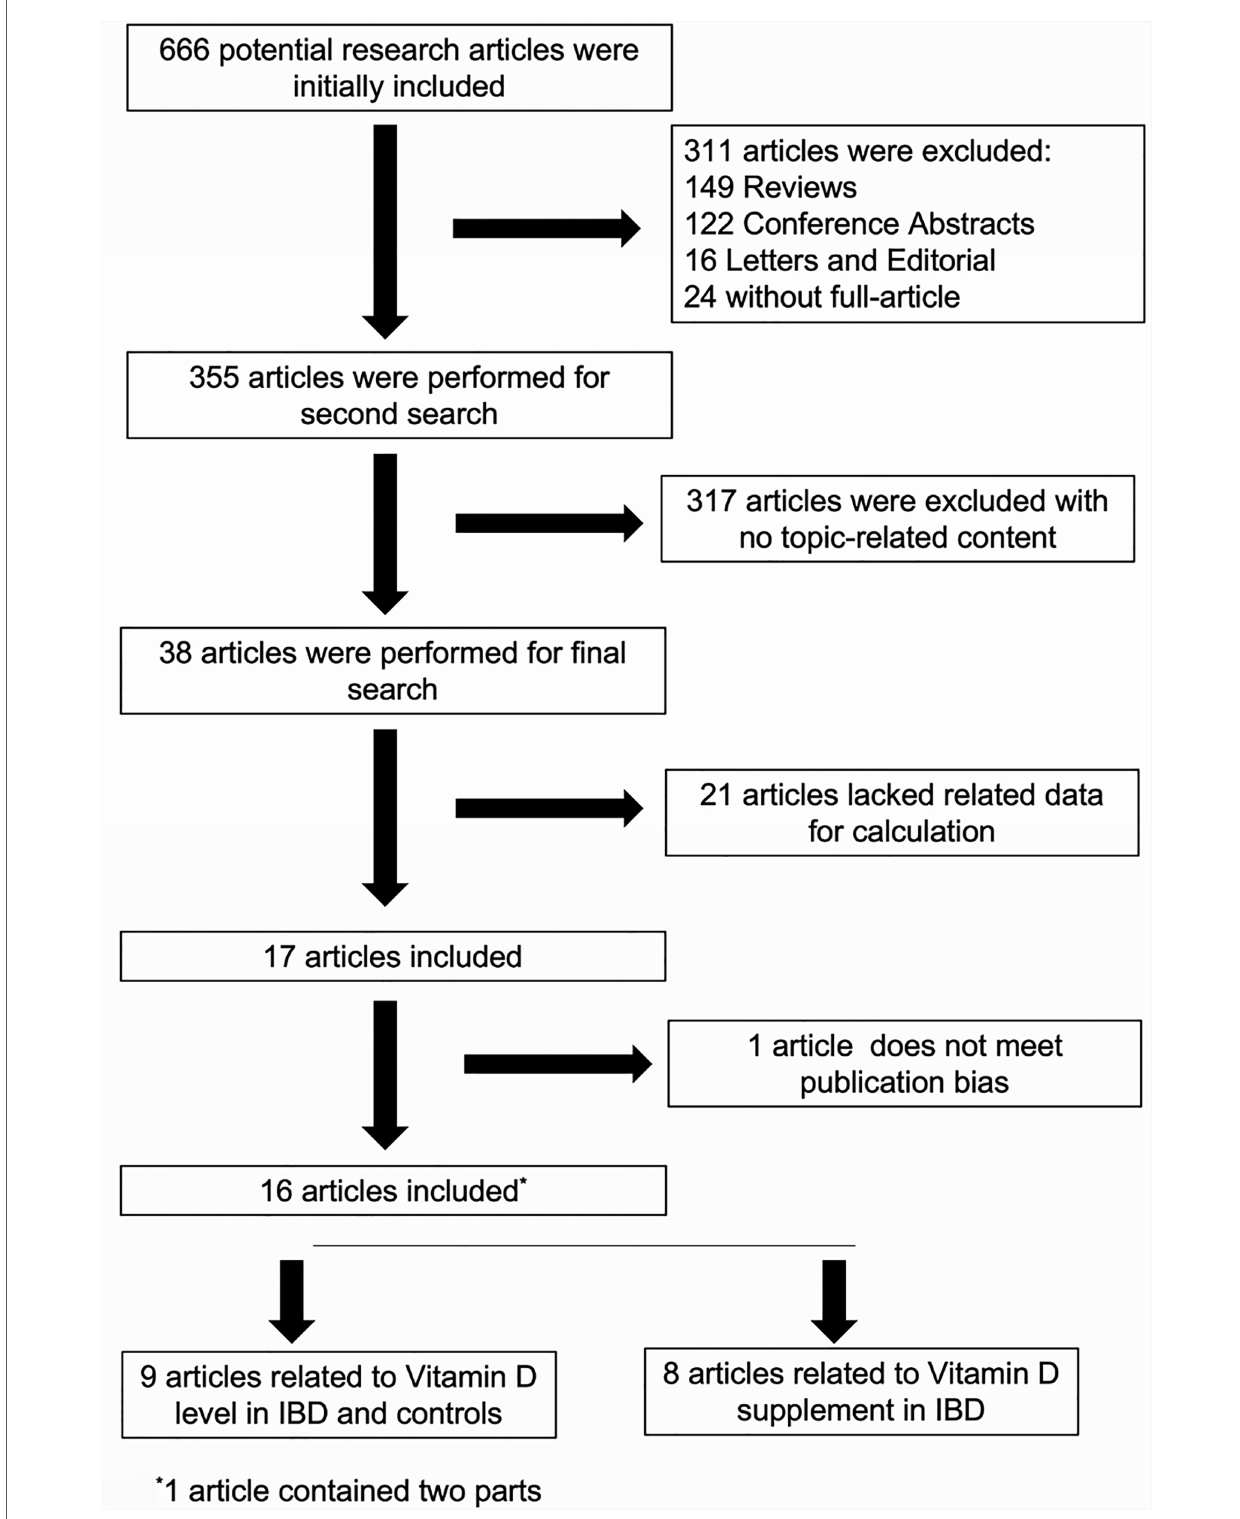
FIGURE 2 Flowchart describing the process of study